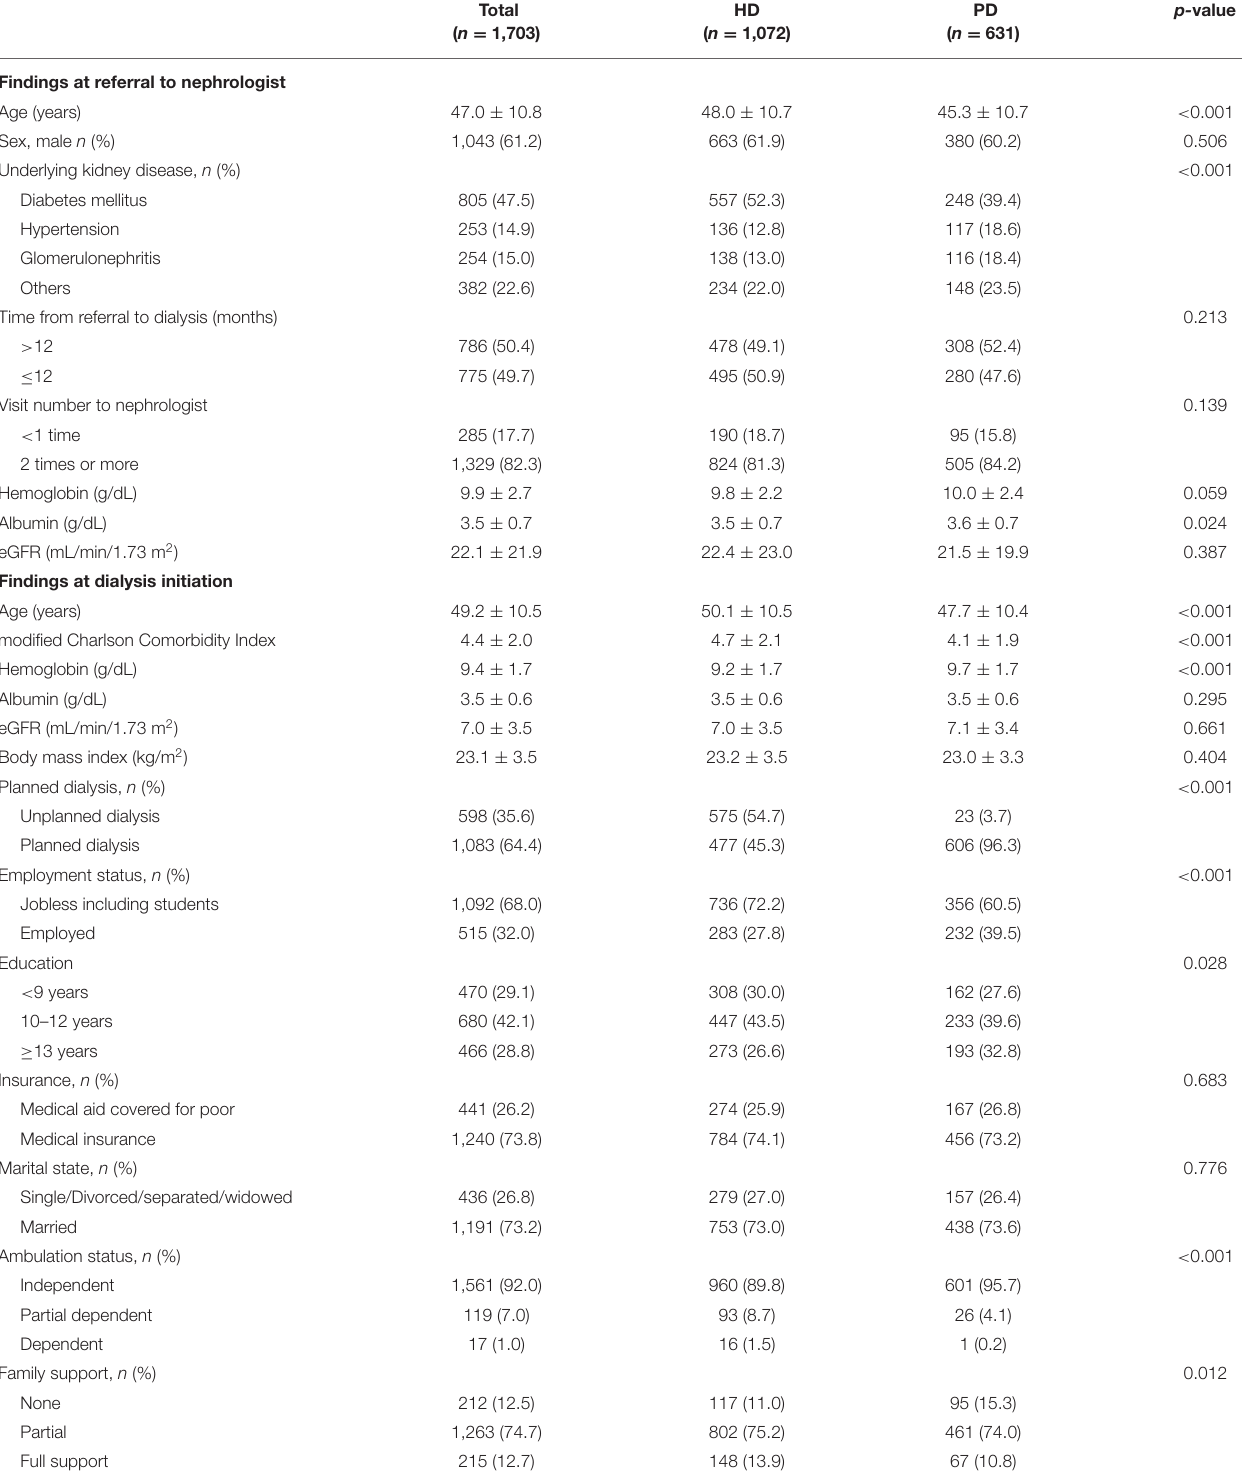
TABLE 2 | Information at referral to nephrologist and dialysis initiation by dialysis modality in younger